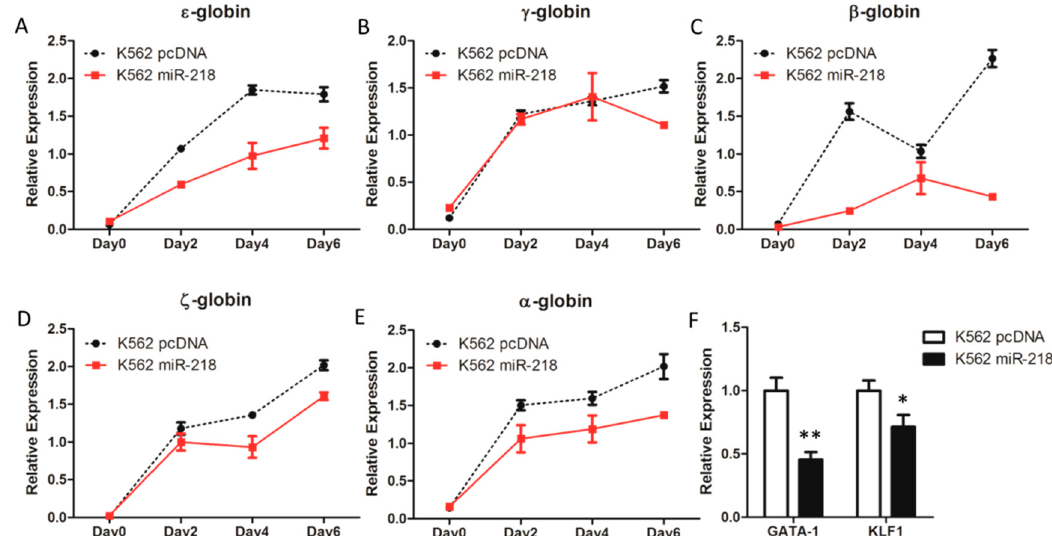
Figure 6. The relative mRNA expression of ε -globin ( A ), γ -globin ( B ), β -globin ( C ), ζ -globin, ( D ) and α -globin ( E ) gene during hemin-induced erythroid differentiation of K562 pcDNA and K562 miR-218 cells was determined using quantitative real-time PCR; ( F ) The expression of GATA-1 and KLF1 in K562 pcDNA and K562 miR-218 cells were also identified by quantitative real-time PCR. All relative mRNA expression using quantitative real-time PCR was normalized to GAPDH and β - actin . Asterisks indicate that differences between samples were statistically significant according to an independent-sample t -test, * p < 0.05, ** p < 0.01.